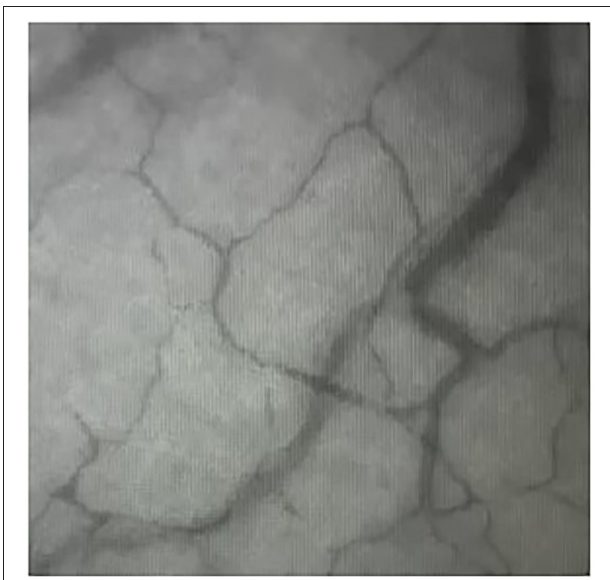
FIGURE 3 | Sidestream dark field videomicroscopy image of the sublingual mucosal capillaries in a cat.